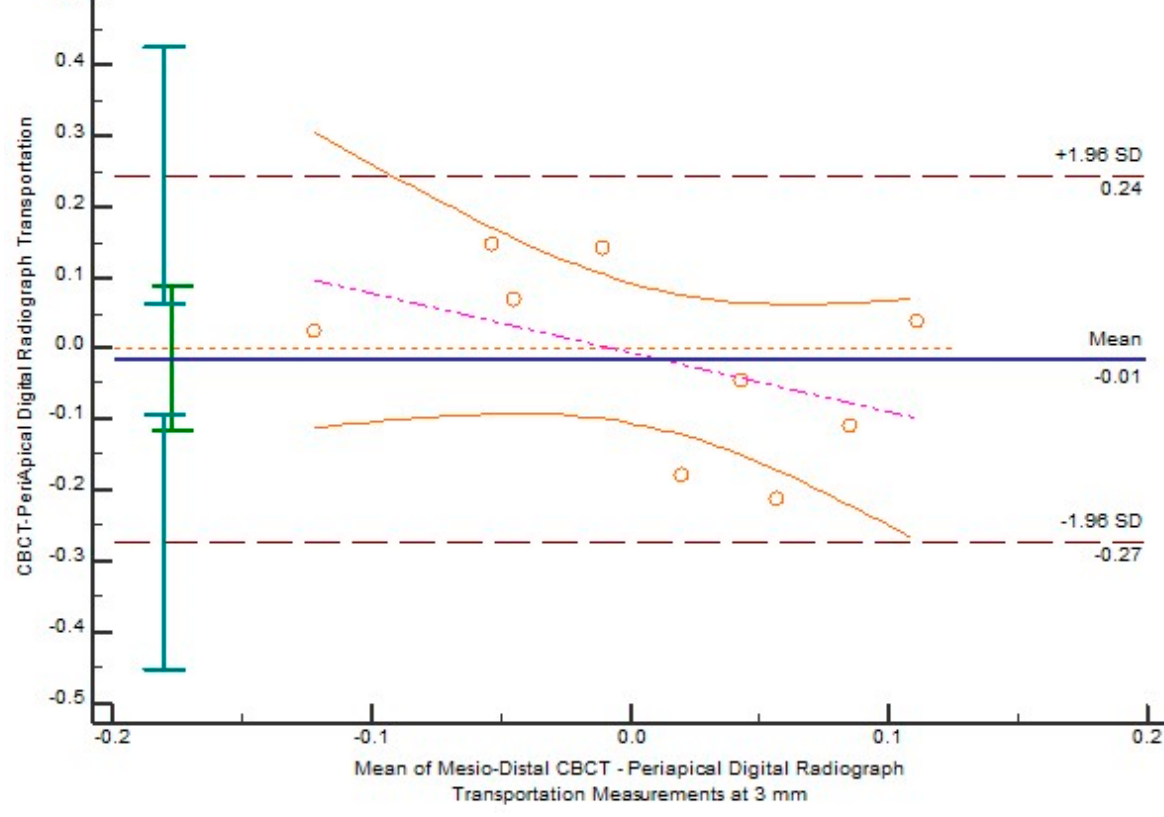
Figure 5. Bland–Altman plot for the agreement between the two methods’ measurements for the transportation in the mesio-distal direction, at a level of 3 mm.